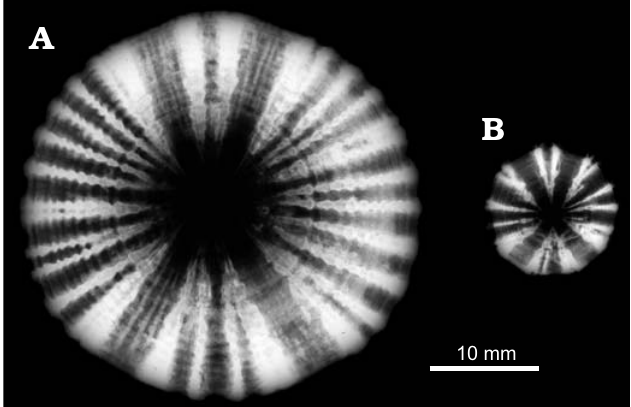
Fig. 9. Radiographs of vertebrae of the mackerel shark Car charo modus escheri (Agassiz, 1843), MNU 071-20, from Groß Pampau, the middle– late Miocene. A . Precaudal vertebra, same as in Fig. 6Q. B . Caudal abdom- inal/caudal vertebra, same as in Fig.